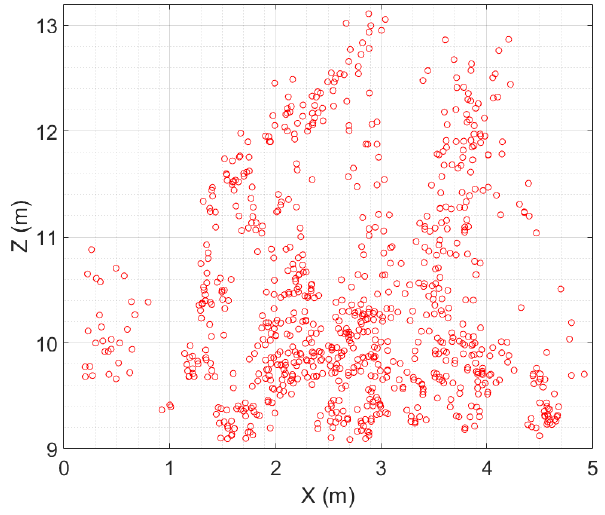
Figure 12. Ground fire 3D points.